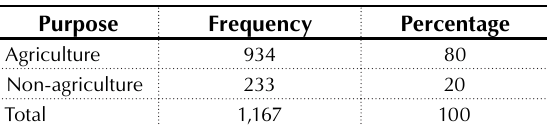
Table 1. The purpose of the agricultural credit